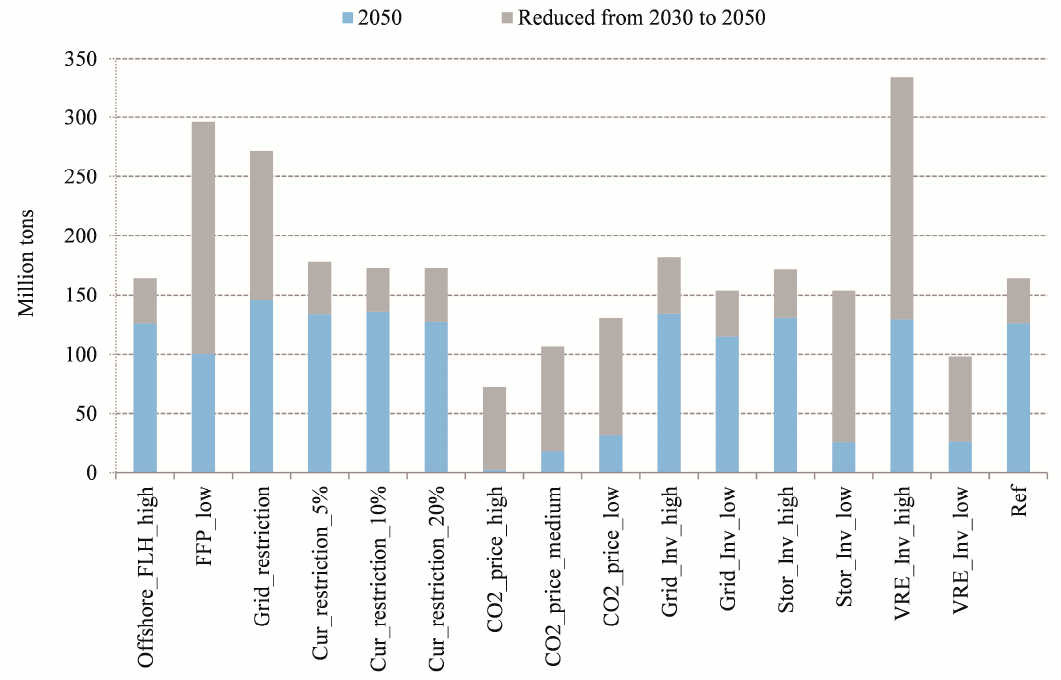
Figure 19. Sensitivity analysis on CO 2 emissions in BTH of 2030 (whole column) and 2050 shown as deviations from the reference scenario.